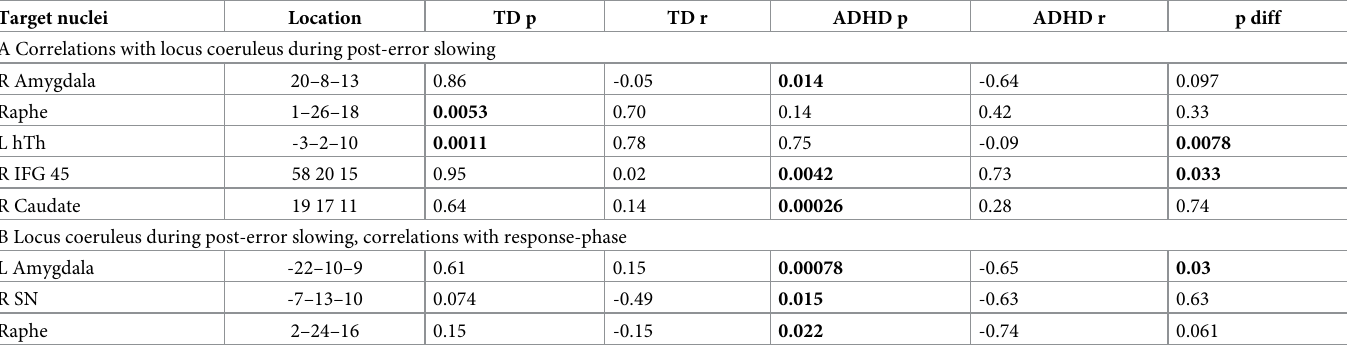
Table 5. Correlations with locus coeruleus